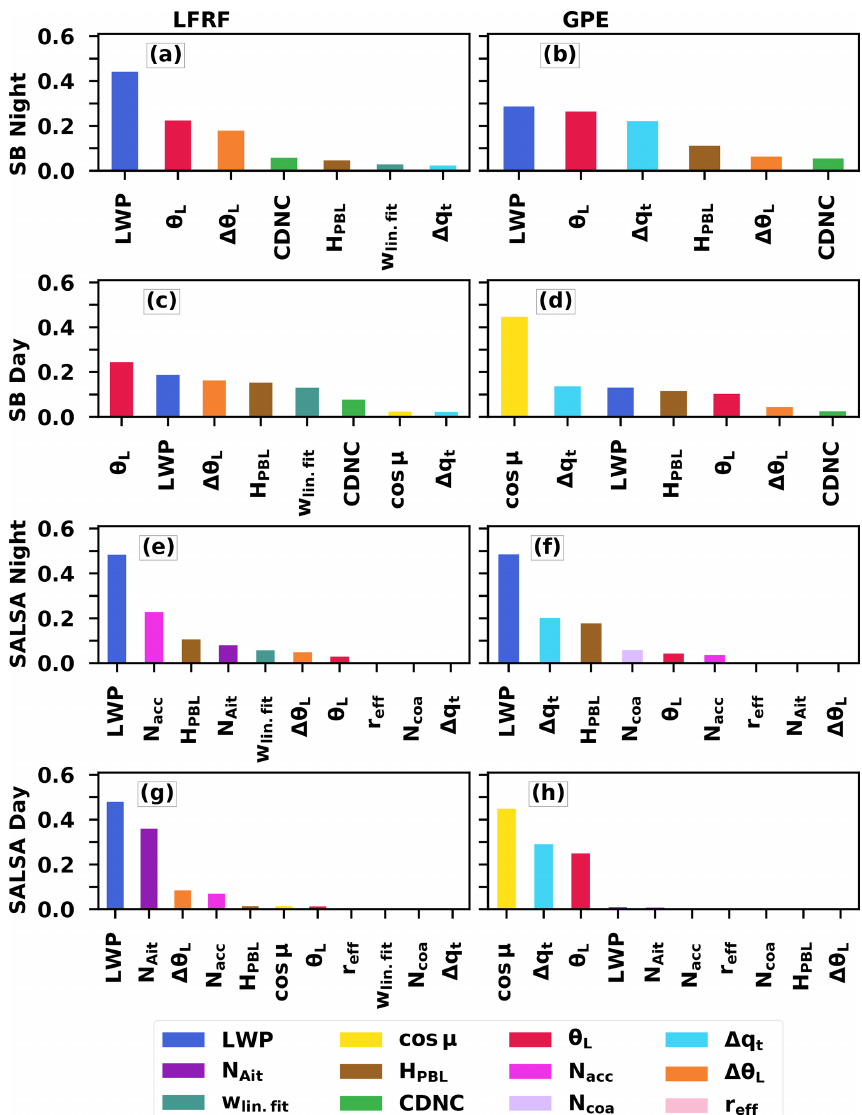
Figure 6. Permutation feature importance of (a, c, e, g) the linear fit improved with random forest (LFRF) and (b, d, f, h) the Gaussian process emulator